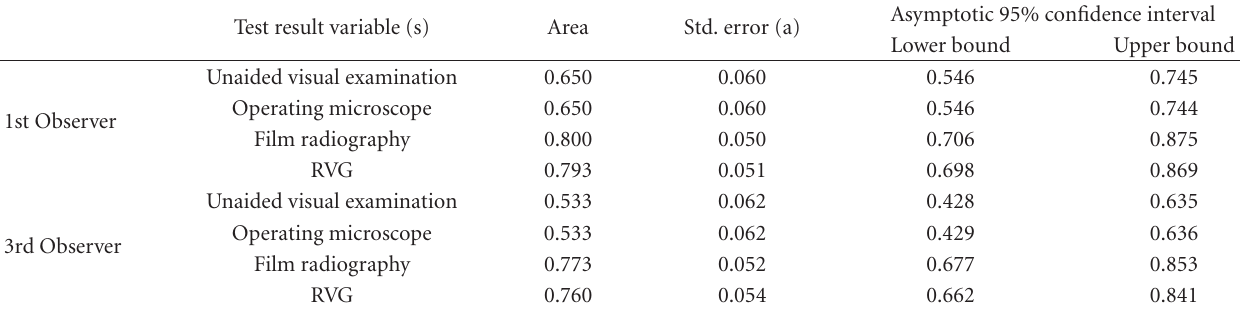
Table 4: The A z values and standard errors for 1st and 3rd